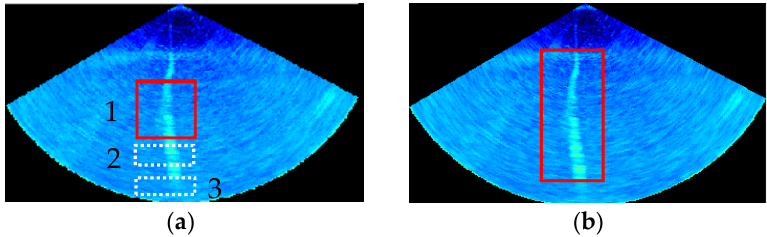
Figure 13. ( a ) The MWC image with initial target detection box. In (a), 1 denotes the detected region